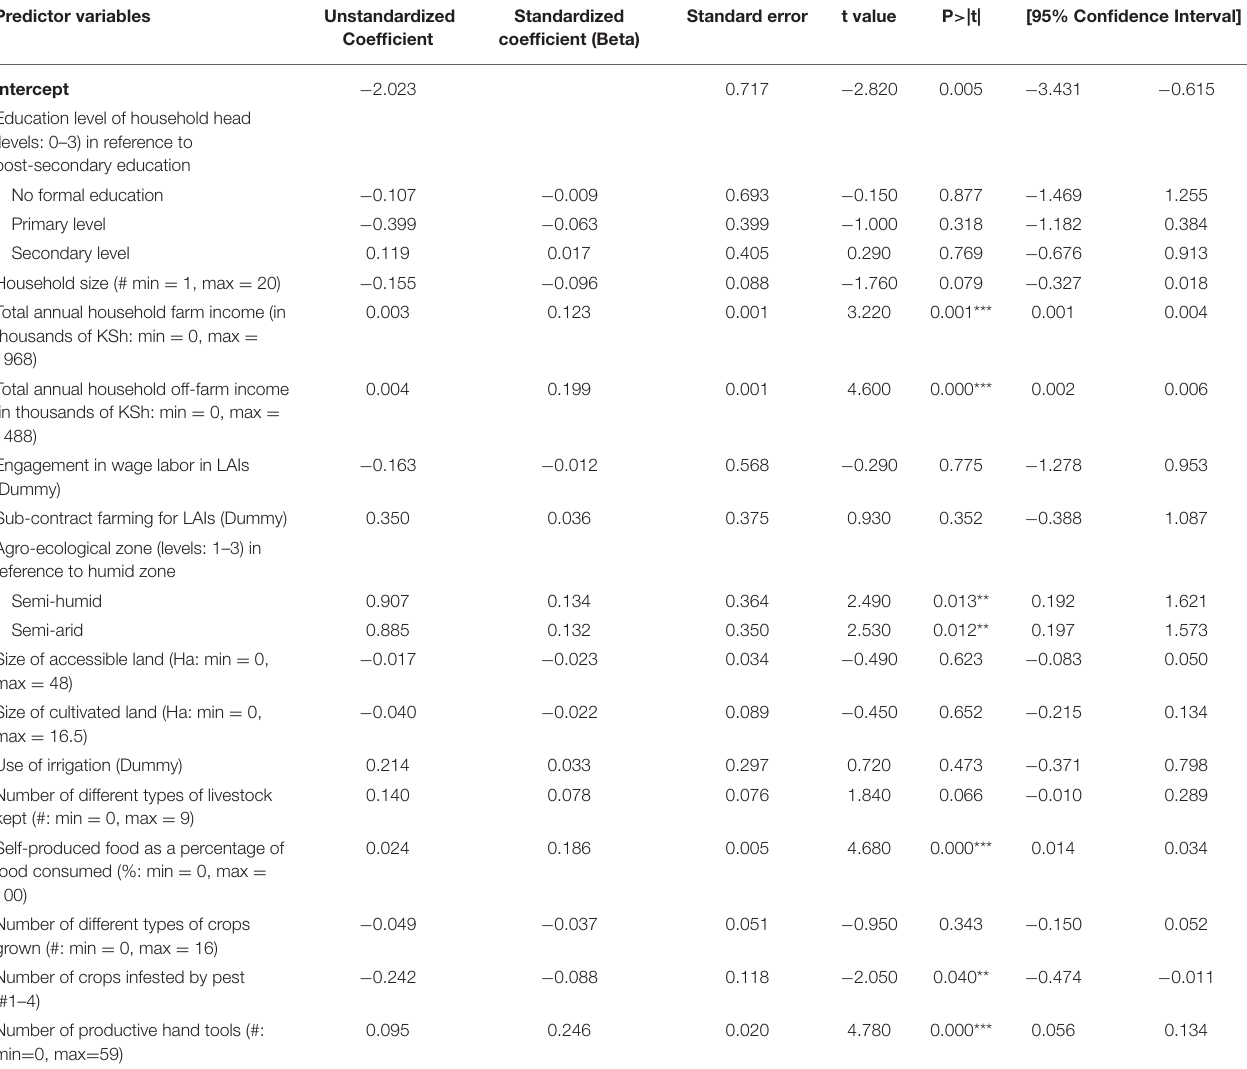
TABLE 6 | Linear regression model with composite FSI using the robust option that take account the heterogeneity showing coefficient estimates of each explanatory variable of food security. Predictor